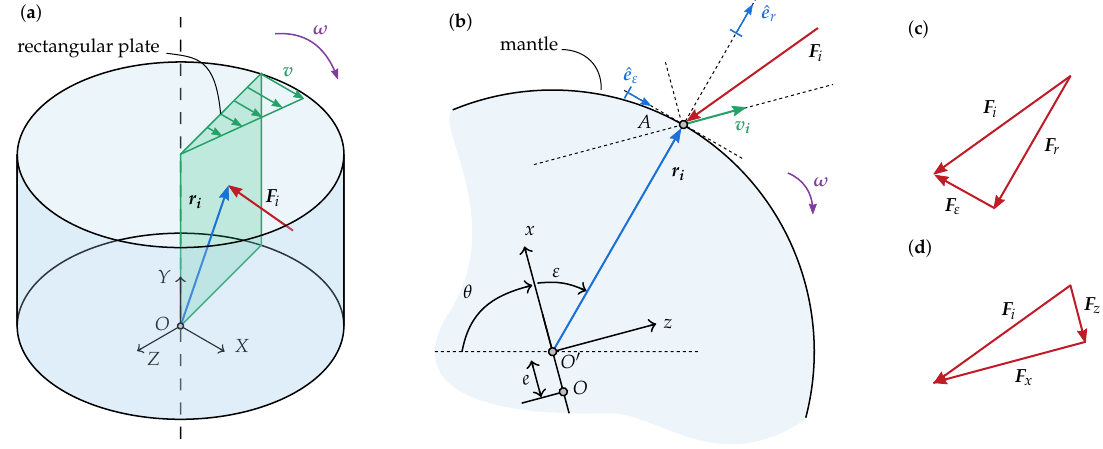
Figure 3. ( a )Mixer with a mobile rectangular plate rotating around the vertical axis. The force F i is applied in the rectangular plate. ( b )Cross-section of the mantle with a vector force, F i , applied at point A . The node i , and all the cross-section, has velocity v i . ( c )Rectangular decomposition of the force, F i , in radial and transverse direction. ( d )Rectangular decomposition of the force, F i , in x -axis and z -axis.